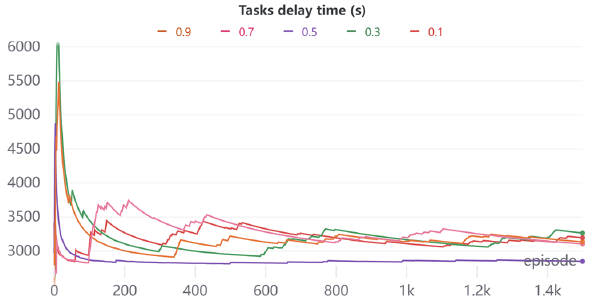
Figure 7. Task delay time of CDA algorithm with different values of 𝛽 .